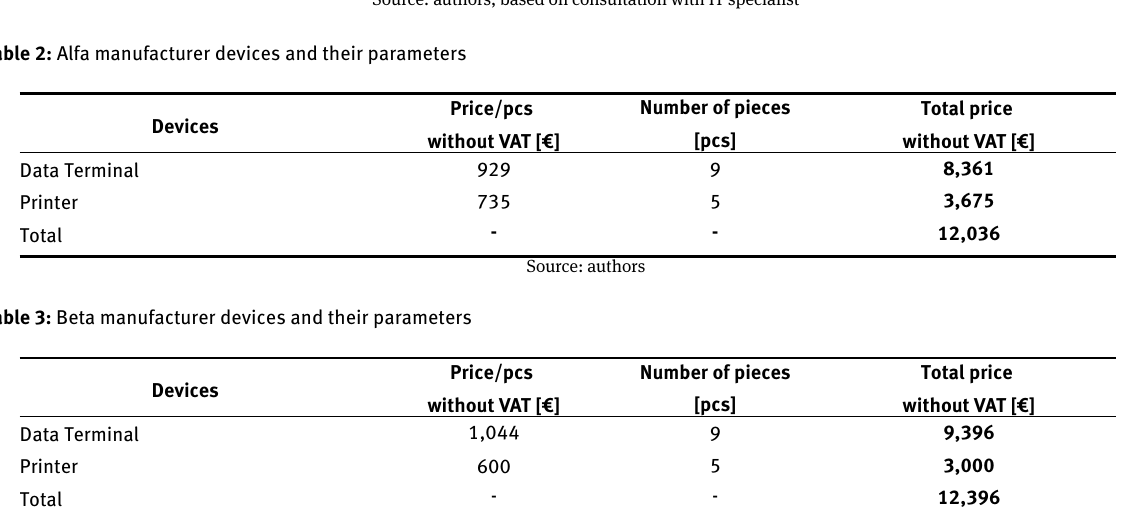
Table 2: Alfa manufacturer devices and their parameters